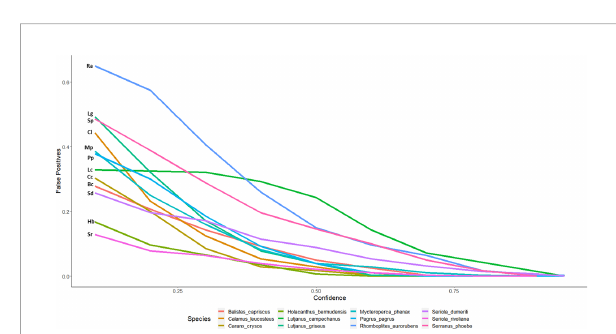
FIGURE 3 False-positive detections of automated counts with top performing model 2.4s to expert derived counts for twelve commercially and ecologically important species of reef fi sh commonly observed in the Gulf of Mexico. Lines are labeled with the initials of the species name in the legend. The false-positive ratio was determined by dividing the number of stations with automated detections when the species was not present in the ground truth, over the total number of stations where the species was not present as determined by the validation